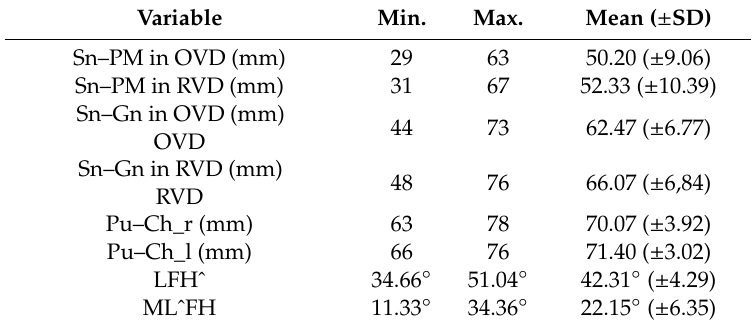
Table 1. Descriptive data of the variables calculated from the clinical cephalometric analysis.